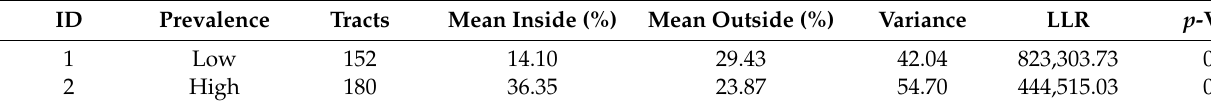
Table 1. Clusters of elevated physical activity.